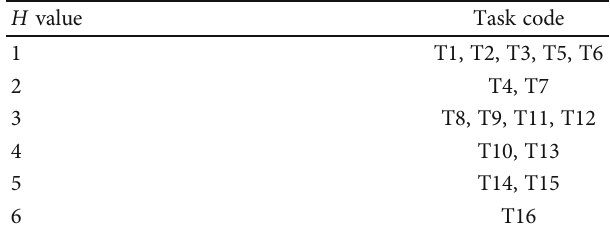
Table 2: H value of each task in Figure 4. H